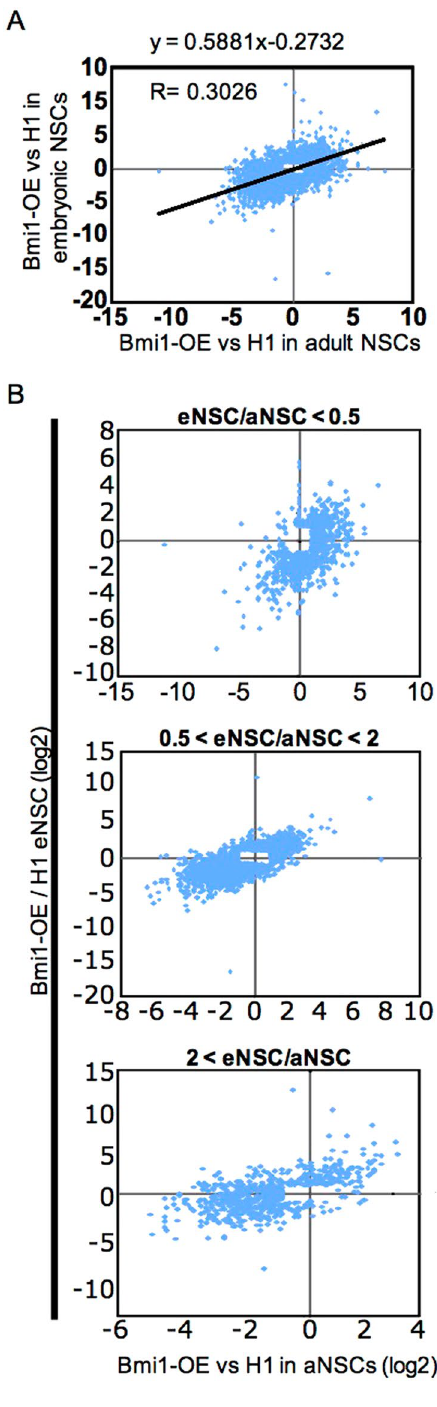
Figure 5. Comparison of gene expression changes in embryonic and adult NSCs caused by Bmi1 overexpression. ( A ) Reads per kilobase per million reads (RPKM) from RNA-seq data from aNSCs and eSNCs is plotted for 4296 genes having expression altered at least two-fold by Bmi1 overexpression in either eNSCs or aNSCs. ( B ) Genes plotted in ( A ) were broken down according to their relative expression in eNSCs and aNSCs as